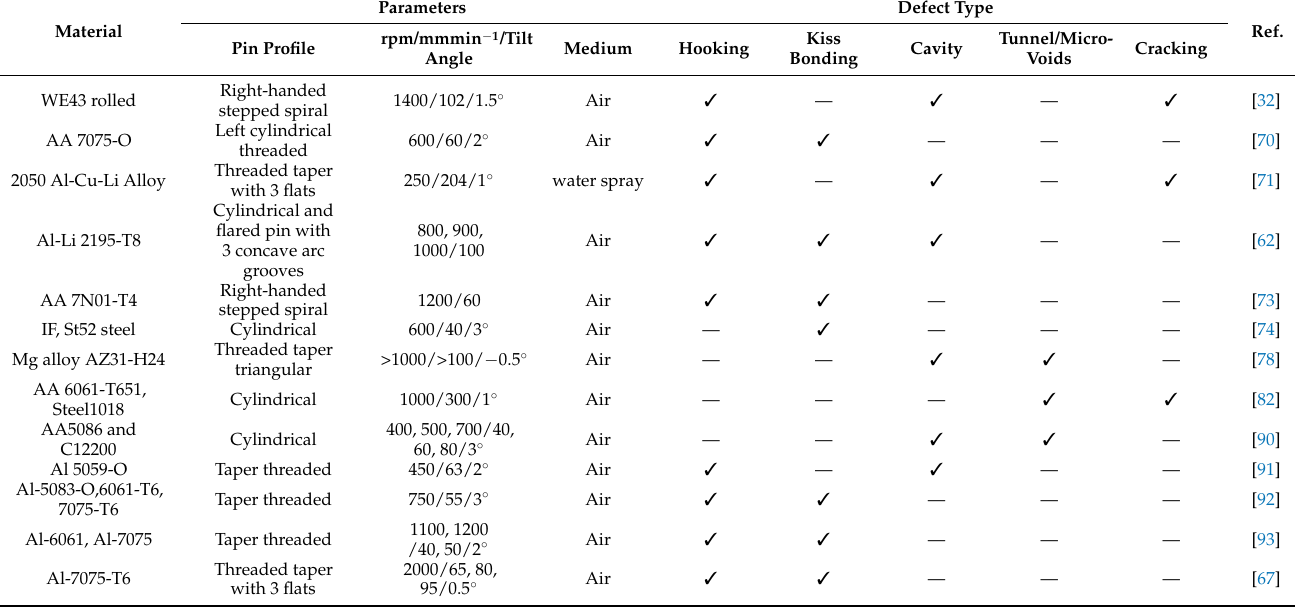
Figure 12. Hooking and cavity defects illustration of Al-li 2195-T8 build fabricated at 800 rpm with single pass and flared pin: Four regions of ( a , b ) A, ( c , d ) B, ( e , f ) C , and ( g , h ) D (reprinted from [62] with permission from Elsevier). Table 5. Summary of microstructural defects originated in the multi-layered build investigated by